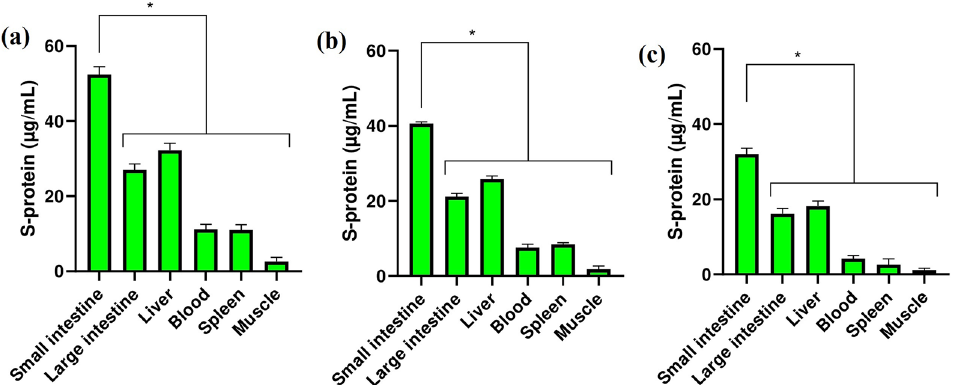
Figure 5. The level of S-protein in major organ or tissues of mice vaccinated with saRNA LNPs ( a ), transfected Lactobacillus plantarum LNPs ( b ), and transfected Lactobacillus plantarum alone ( c ). * indicates significance difference with P < 0.05 using one-way ANOVA with n = 10 biologically independent mice. All data were shown as mean ±